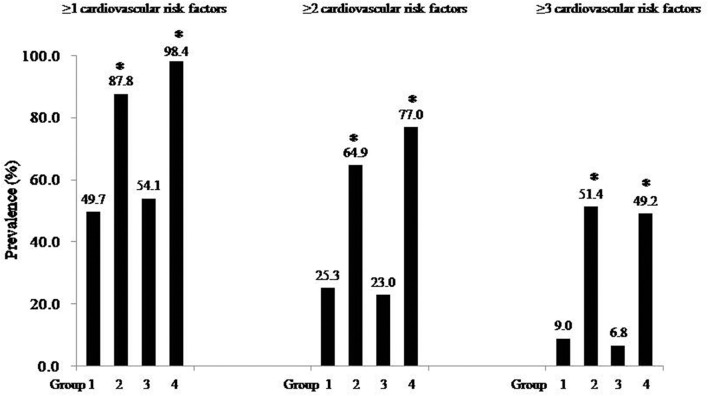
Prevalence of cardiometabolic risk factors among four groups. Group 1: childhood BMI z-scores < 75th percentile and adult BMI z-scores < 75th percentile; Group 2: childhood BMI z-scores < 75th percentile and adult BMI z-scores ≥ 75th percentile; Group 3: childhood BMI z-scores ≥ 75th percentile and adult BMI z-scores < 75th percentile; Group 4: childhood BMI z-scores ≥ 75th percentile and adult BMI z-scores ≥ 75th percentile. *P < 0.001 (Compared with group 1).